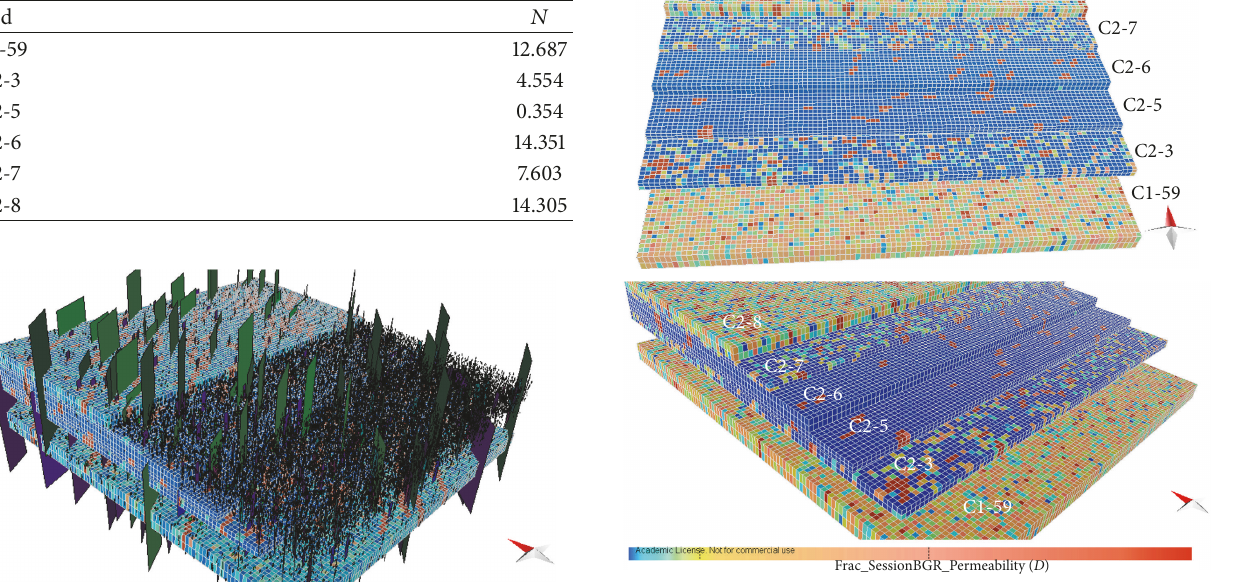
Figure 6: Discrete fracture network model (10000m 2 at the base and height proportional to the measured layer thickness) populated with analysed fractures for each bed.